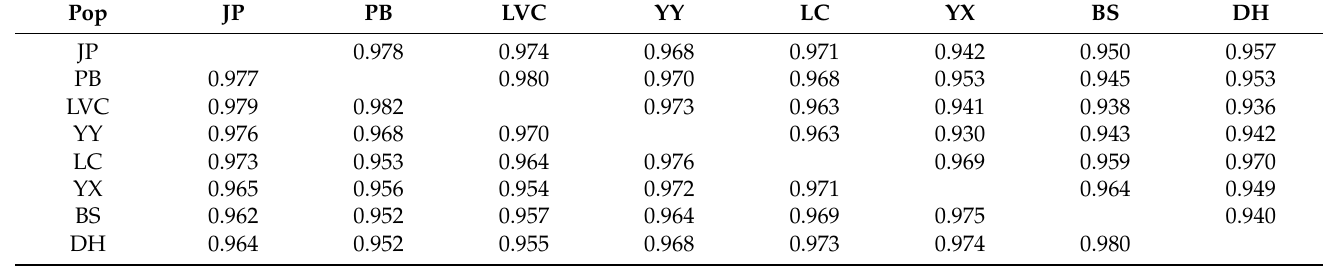
Table 7. Pairwise Nei’s genetic identity based on PAAP (above diagonal) and CDDP (below diagonal) between A. tsaoko populations.